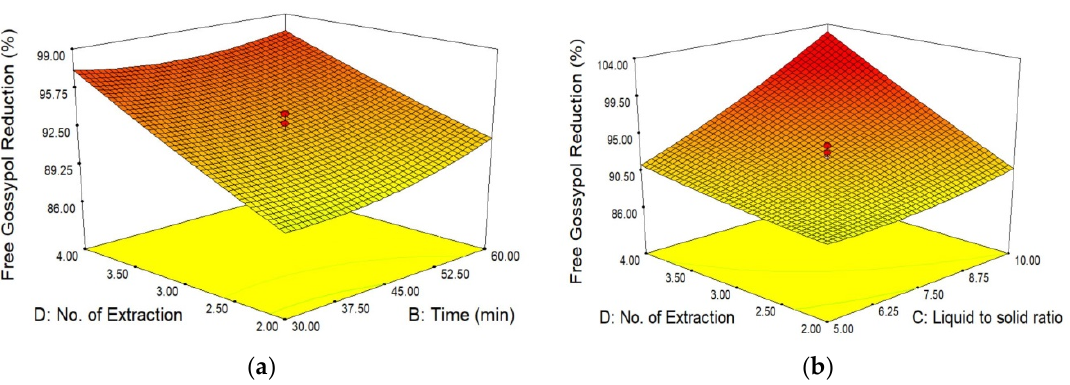
Figure 7. ( a ) 3D surface plot between no. of extraction cycles and time of extraction ( b ) 3D surface plot between no. of extraction cycles and LSR.